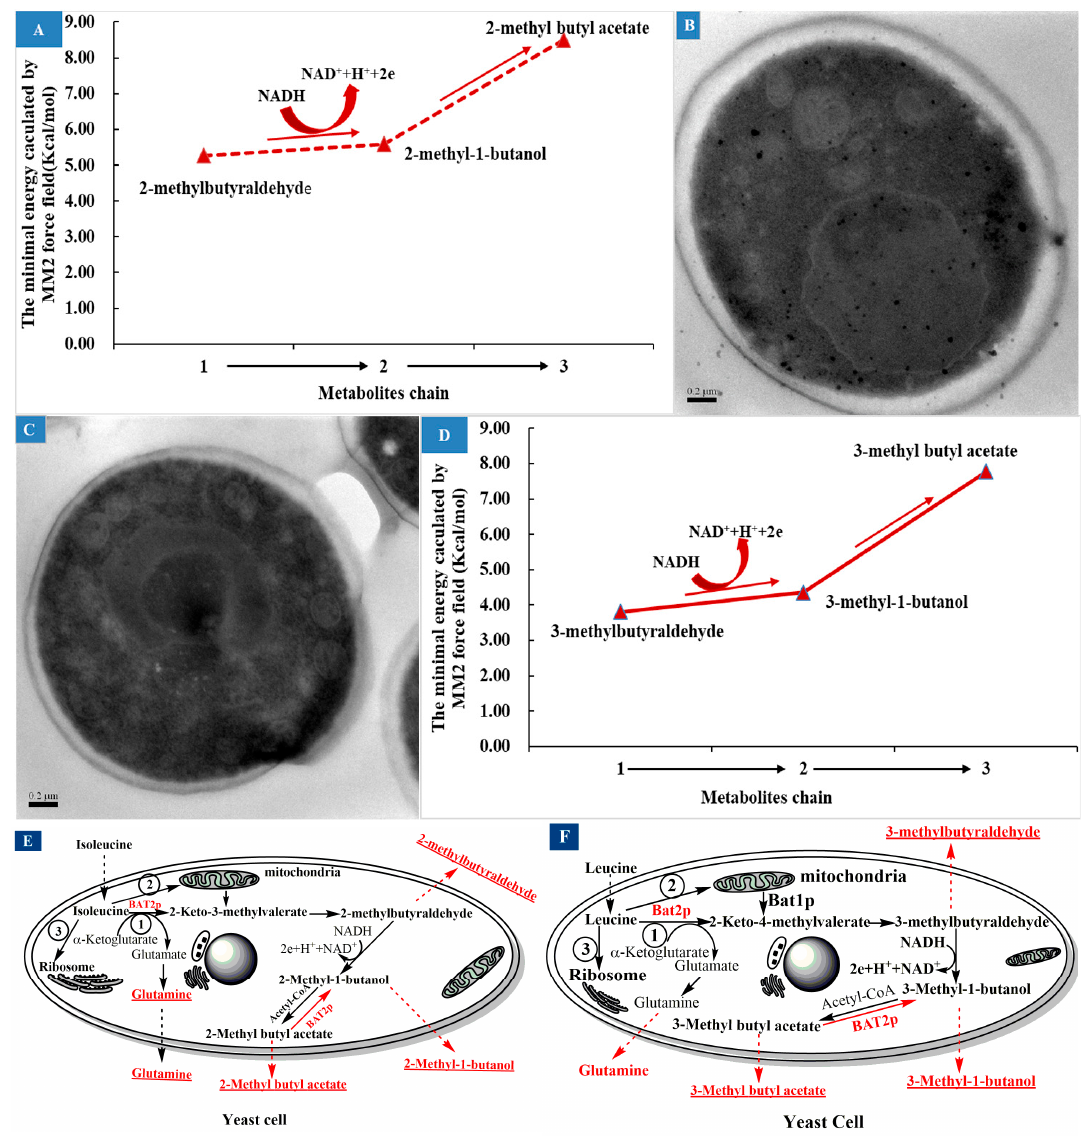
Figure 5. The metabolite chain analysis of Ile and the potential effects of BAT2 gene on the chain. ( A ) The simulation analysis of the substance and energy metabolism chain of Ile. ( B ) A representative transmission electron microscope photo of parental S. cerevisiae 38 in M1 (0.5 M Ile+SCD). ( C ) A representative transmission electron microscope photo of BAT2 mutant 38 in M1 (0.5 M Ile+SCD). ( D ) The simulation analysis of the substance and energy metabolism chain of Leu. ( E ) The improved catabolism pathway of Ile and Bat2p regulation. ( F ) The improved catabolism pathway of Leu